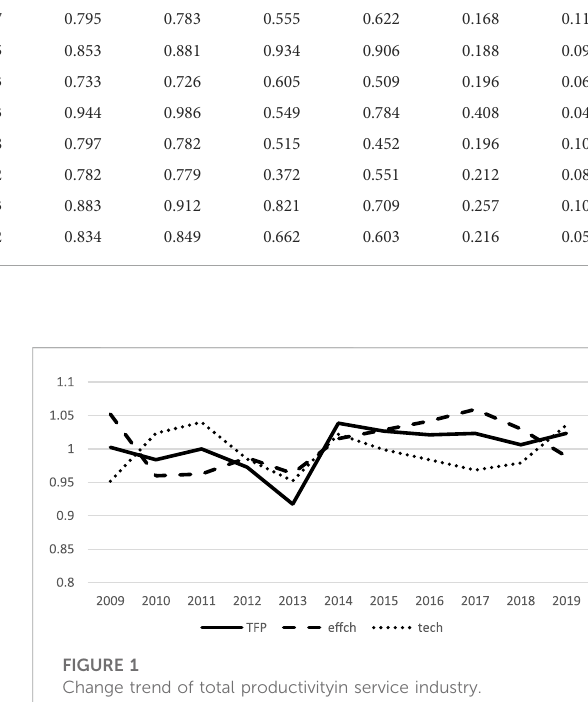
FIGURE 1 Change trend of total productivityin service